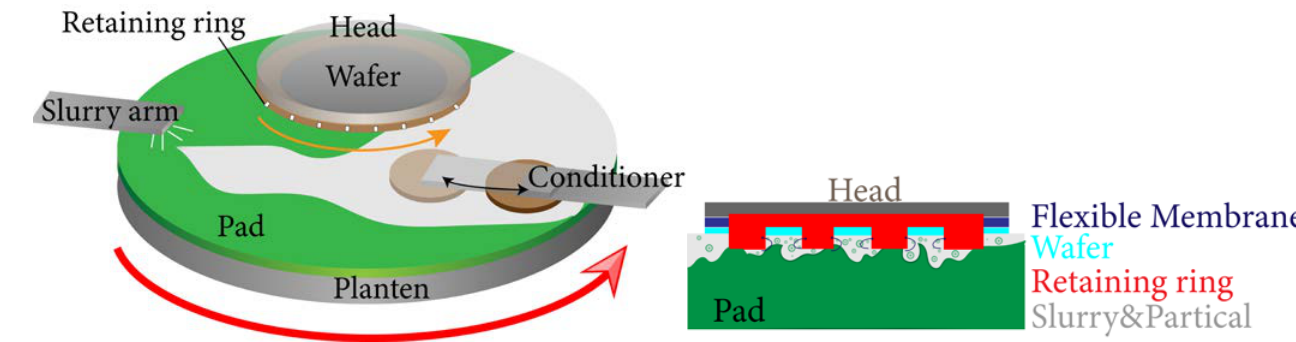
Figure 3. Schematic diagram of CMP process.